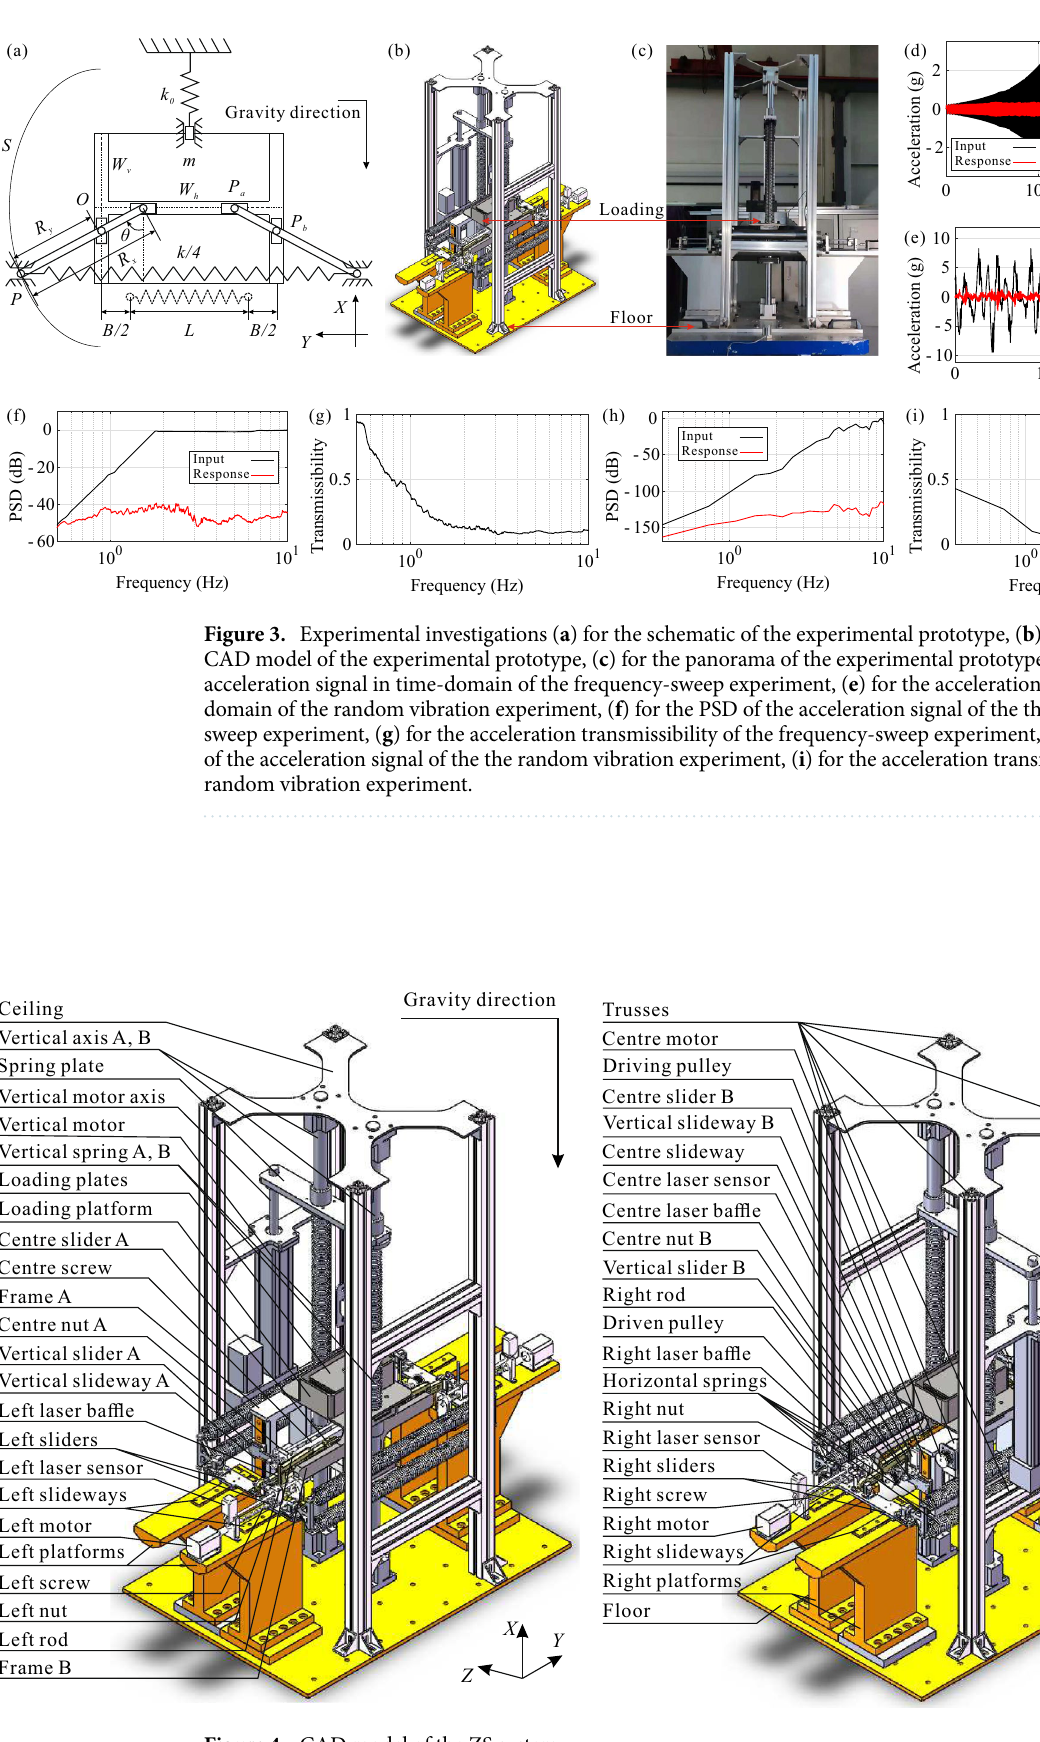
Figure 4. CAD model of the ZS